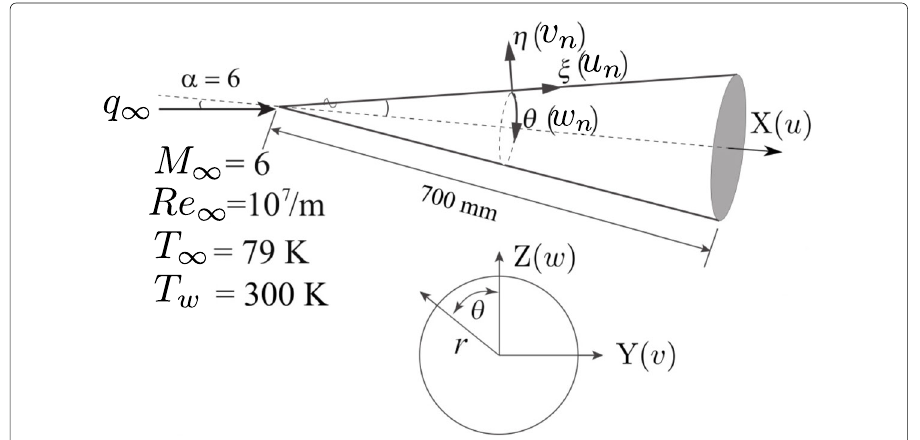
Fig. 1 The sketch of the simulation, notations and